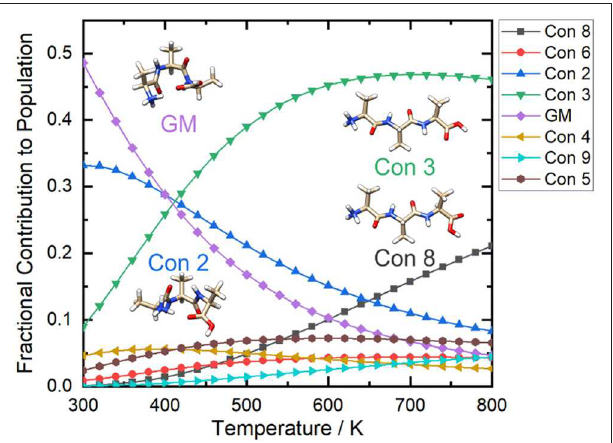
H] + as a function of +